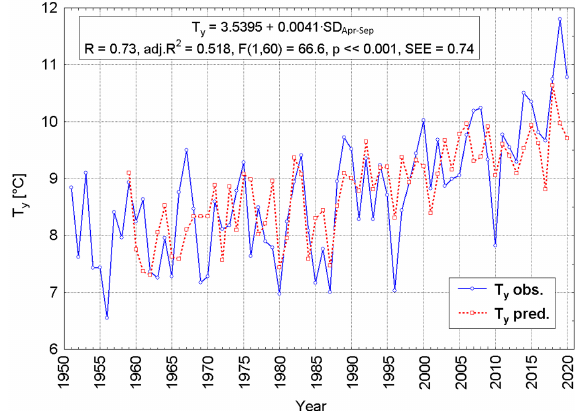
Fig. 6. The annual temperature observed (T and estimated (T pred.) in Poznań in 1951–2020 as a y function of the insolation of the warm